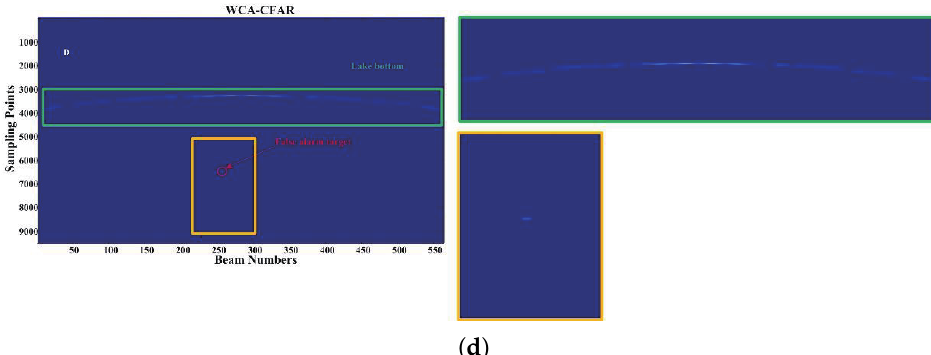
Figure 10. Comparison results of the constant false alarm detection methods in the lake experi- ments: ( a ) the 2D-CA-CFAR method; ( b ) the 2D-SO-CFAR method; ( c ) the 2D-GO-CFAR method; ( d ) the 2D-WCA-CFAR method.